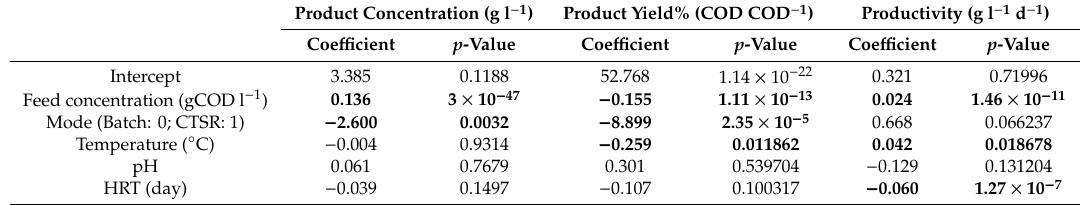
Table 6. Regression coe ffi cients and their associated p -values. Values in bold indicate a significant e ff ect ( p -value <